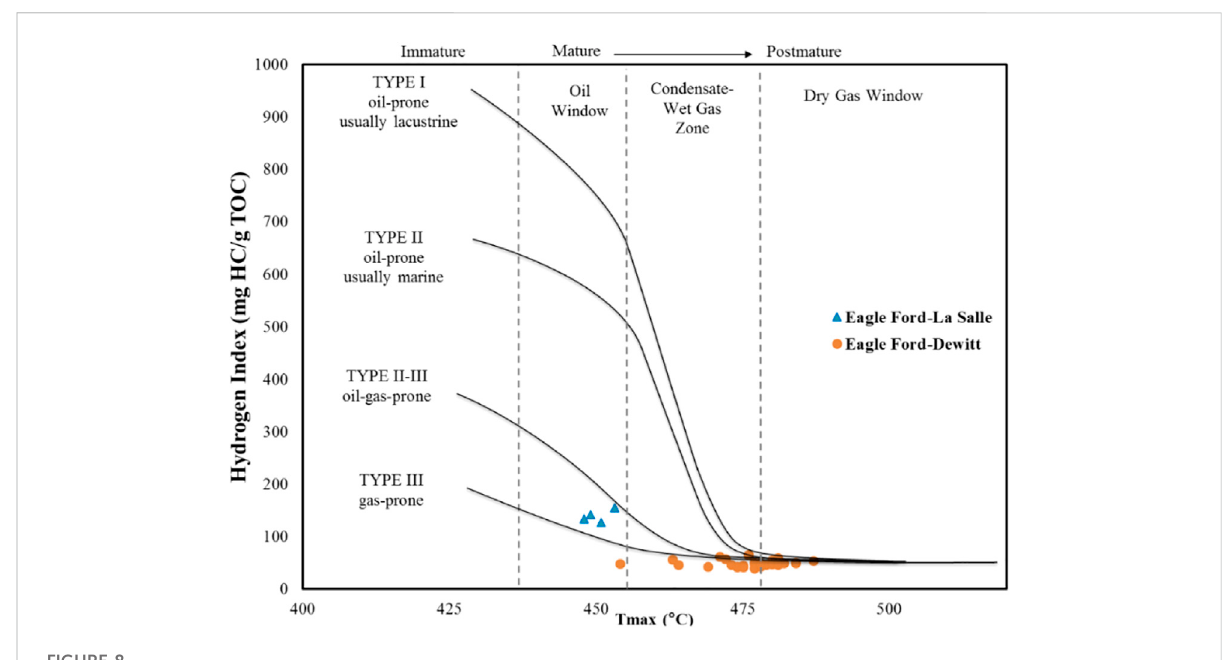
FIGURE 8 Maturity level of two Eagle Ford